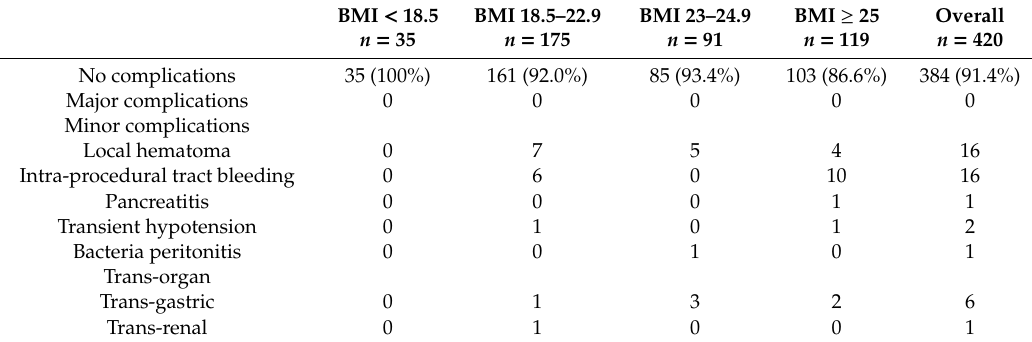
Table 4. Safety profiles.